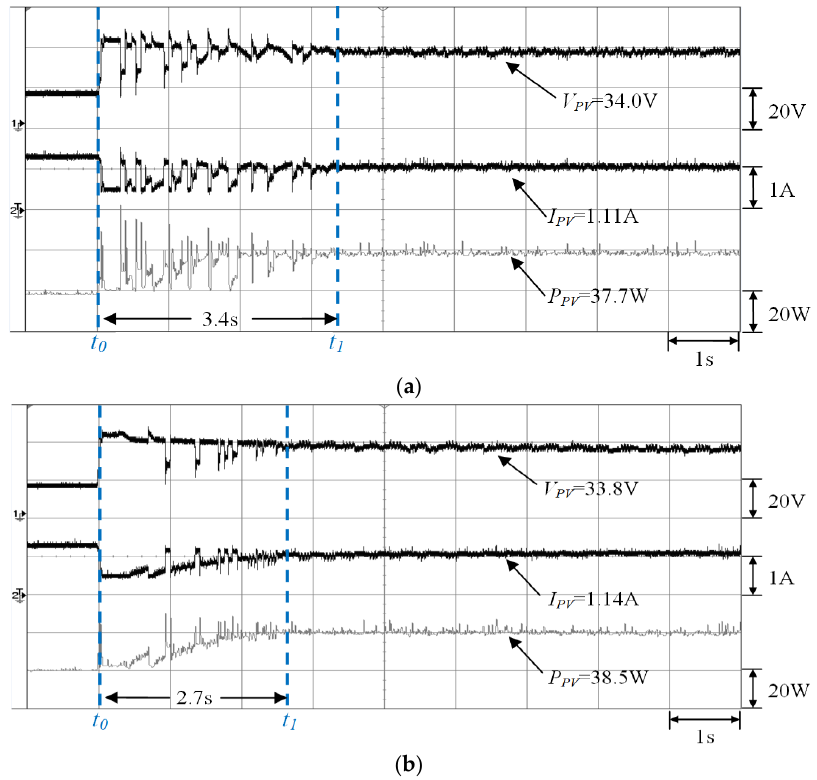
Figure 14. Measurement results of the three-serial and one-parallel module array (0%, 30%, and 70% shading) by using ( a ) conventional TLBO ( P mp = 37.7 W) and ( b ) the proposed I-TLBO ( P mp = 38.5 W).